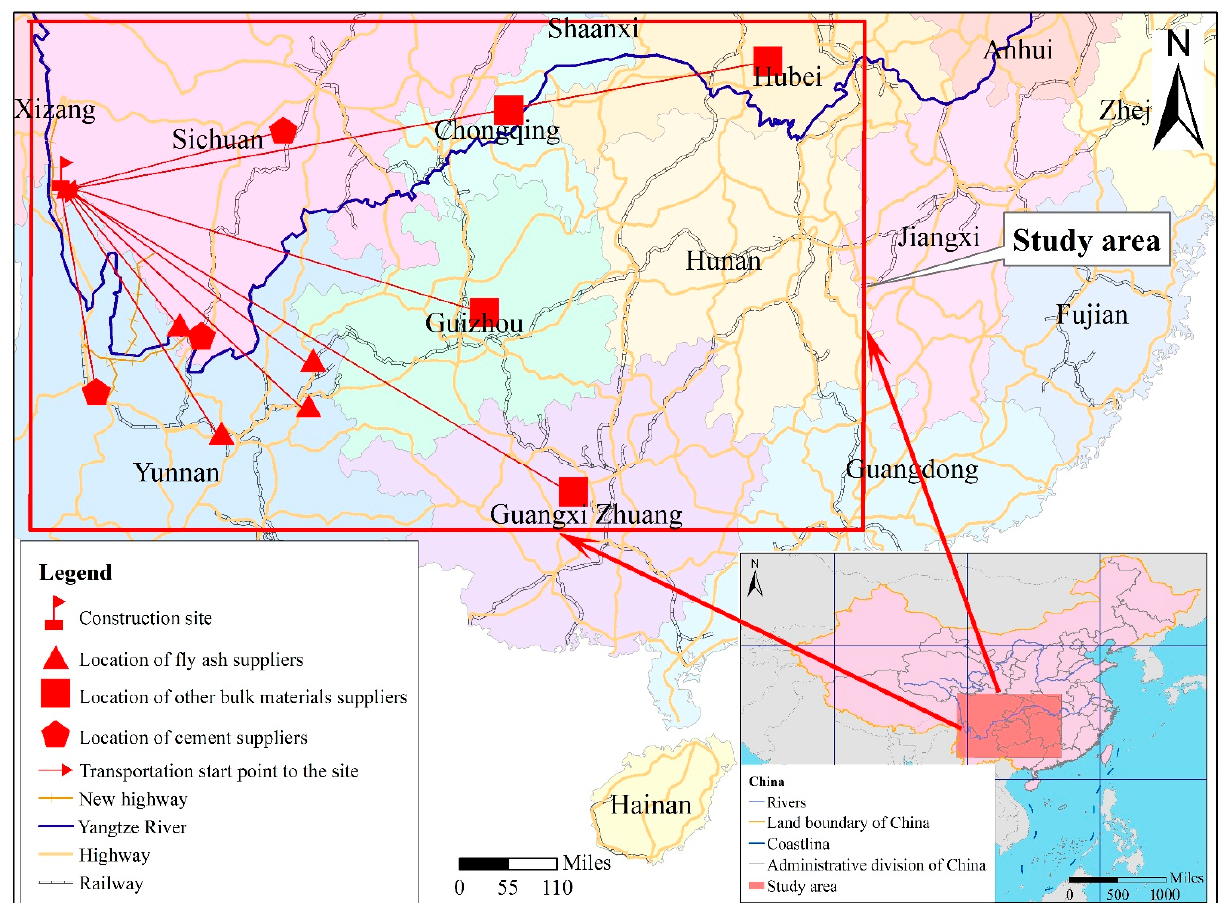
Figure 1. The bulk materials transportation network of a hydropower project in China.